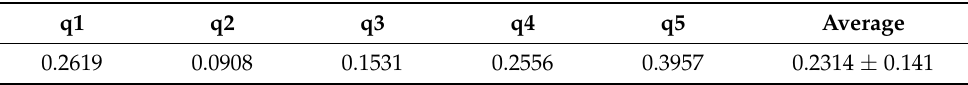
Table 10. Average pairwise highlights agreement on each question over all human evaluators. The pairwise agreement is calculated as the ratio between the intersection and the union of the two sets of